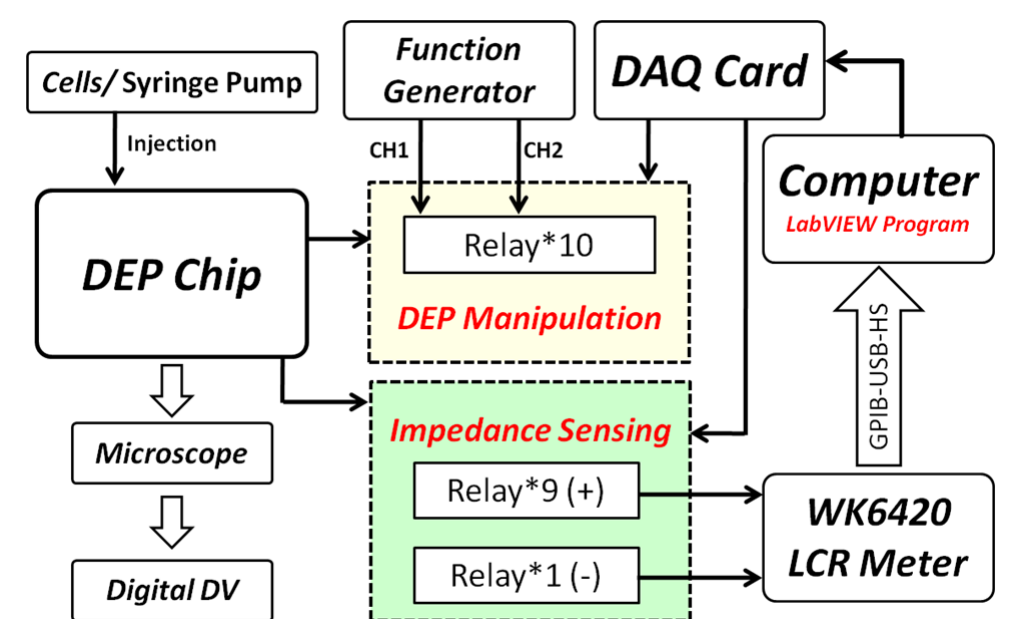
Figure 8. The experimental setup for DEP trapping, releasing and impendence sensing of